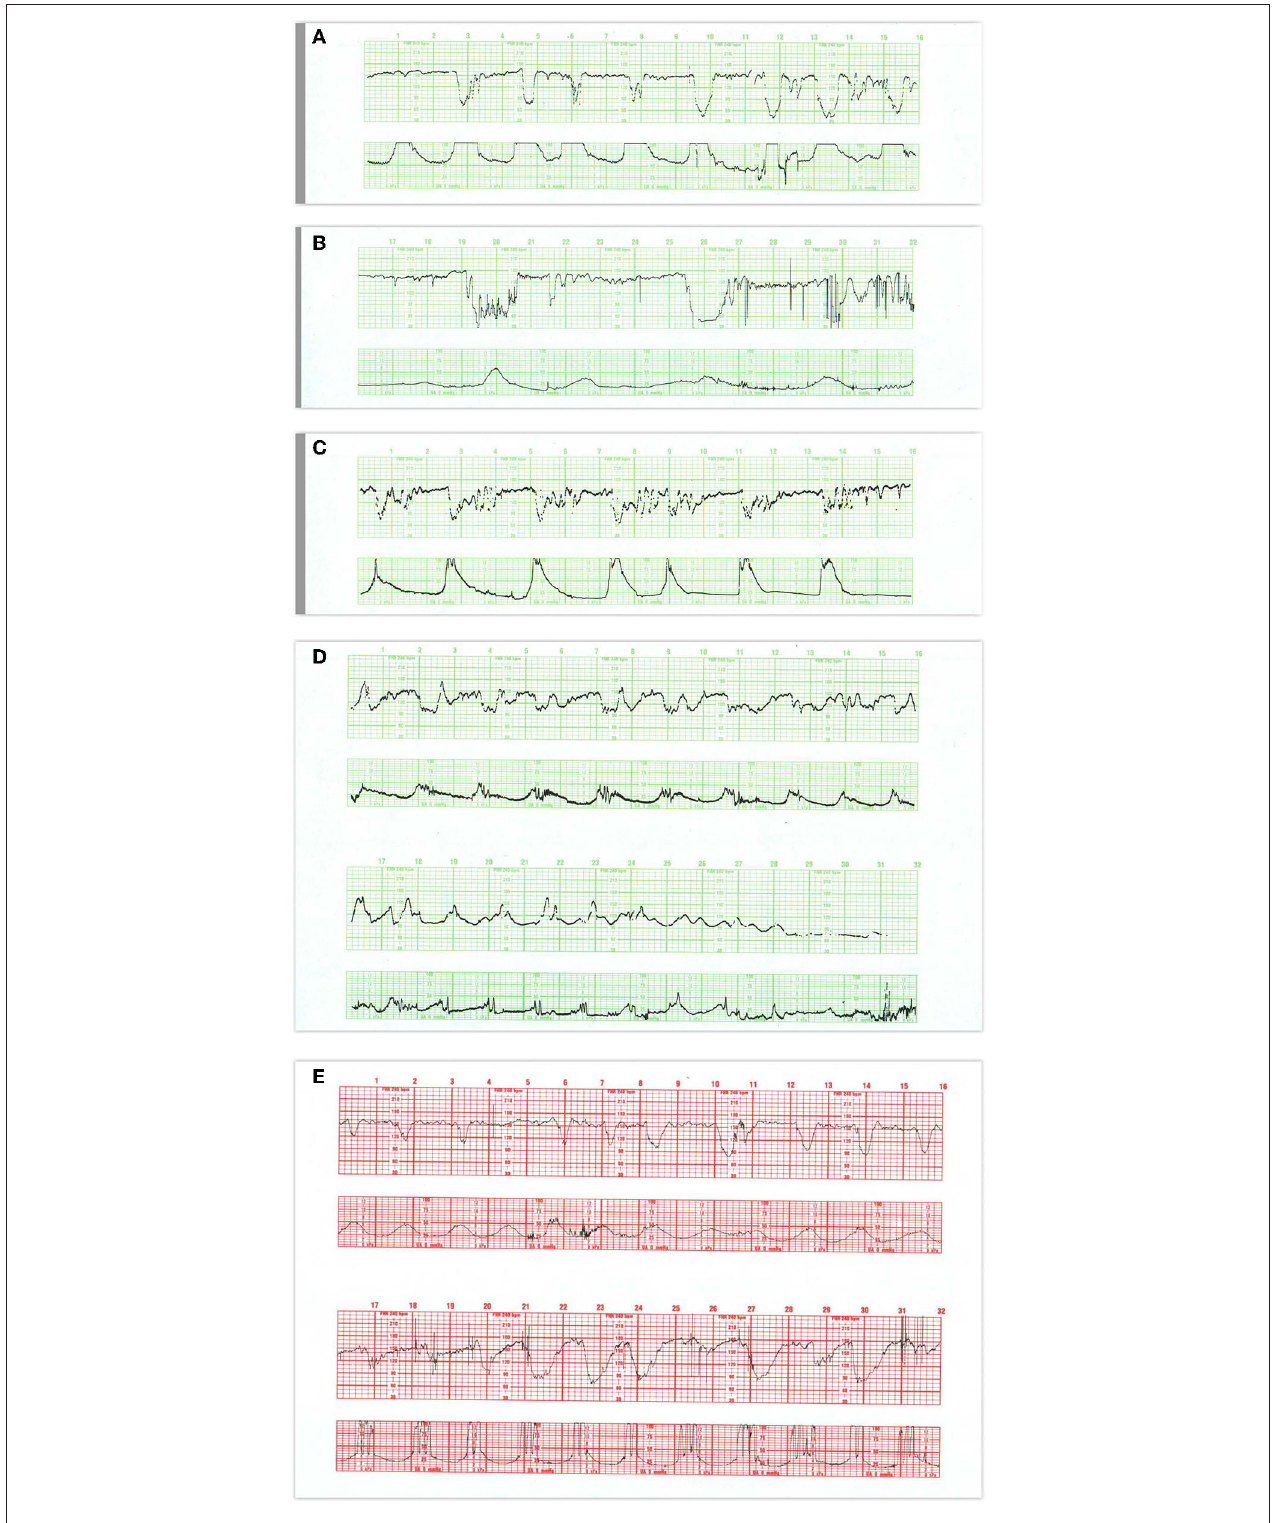
FIGURE 8 | (A) Demonstrates the typical FHR pattern associated with occiput-posterior positions during the second stage of labor. The tracing is dominated by recurrent, variable decelerations, some of which reach 60 bpm and develop transient, nodal rhythm (9M, 11M, and 13M). Despite the frequent decelerations and contractions (10 per 16min), the baseline rate remains quite stable without loss of variability. The frequent accelerations (“shoulders”) both initiate and follow the